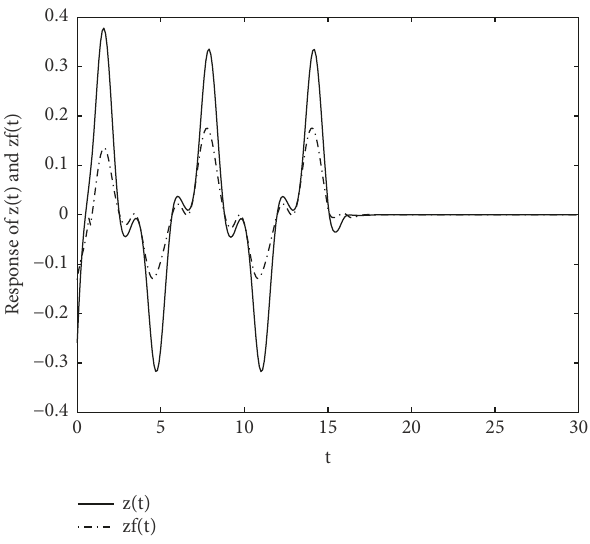
Figure 2: The response curve of system states 𝑥 𝑓1 , 𝑥 𝑓2 .